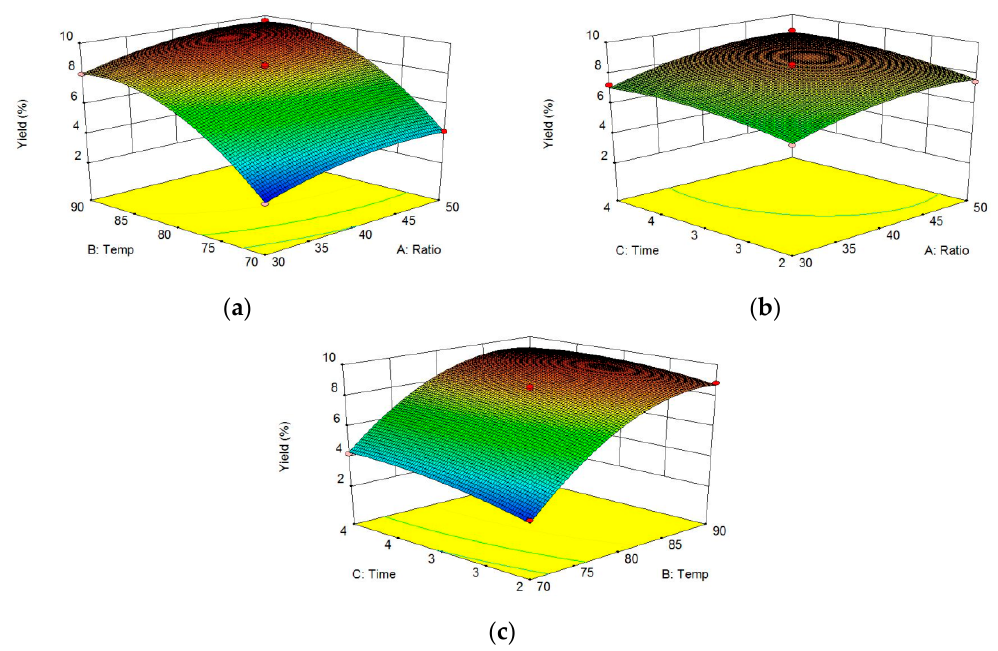
Figure 2. Response surface and contour plots for the effects of different parameters on Chlorella -Arc polysaccharide yields. ( a ) Ratio of water to dried microalgae powder and extraction temperature, with the extraction time held constant at 3 h. ( b ) Ratio of water to dried microalgae powder and extraction time, with the extraction temperature held at 80 °C. ( c ) Extraction temperature and extraction time, with the ratio of water to dried microalgae powder fixed at 40:1.